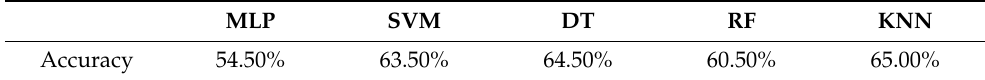
Figure 10. Classification accuracy according to k parameter of KNN on Dataset 06.